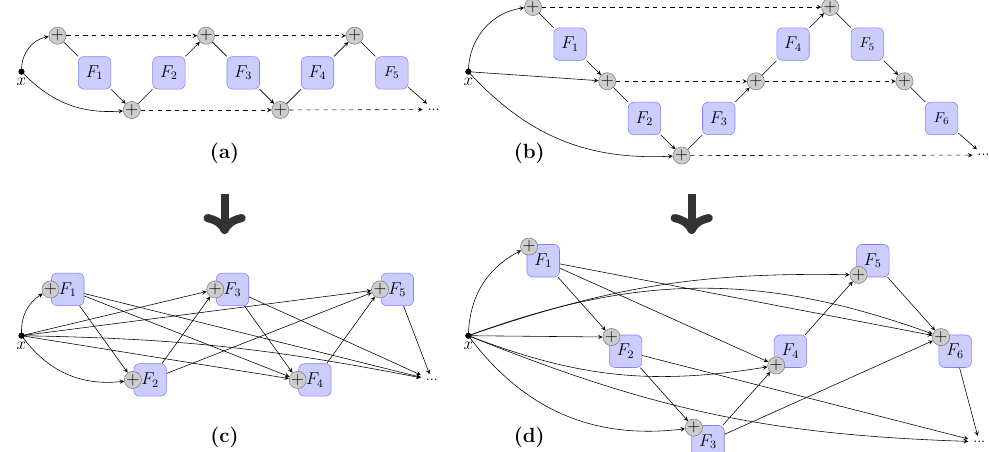
Figure 2. Example of mapping from FoldNet to DAGs. ( a ) An example of FoldNet-2. ( b ) An example of FoldNet-3. The F i nodes represent non-linear transformations among data; the circles with plus signs inside represent summation of all ingoing data. ( c ) The directed acyclic graph mapped from FoldNet-2. ( d ) The directed acyclic graph mapped from FoldNet-3. The nodes are composition of summation and non-linear transformations; the lines represent data flows among nodes.